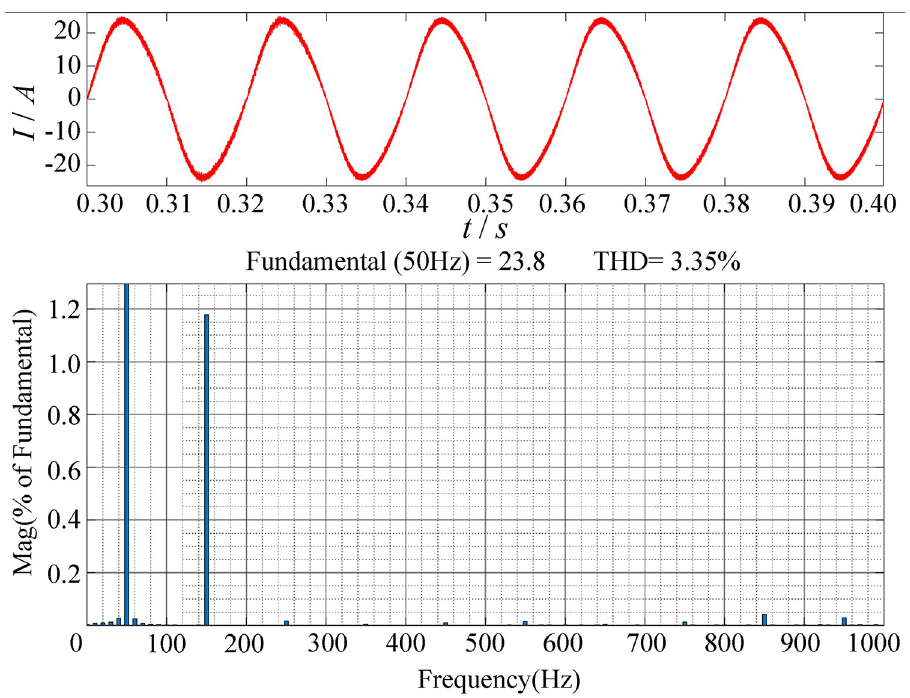
Fig 18. Diagram of the harmonic content of the PFC input current.